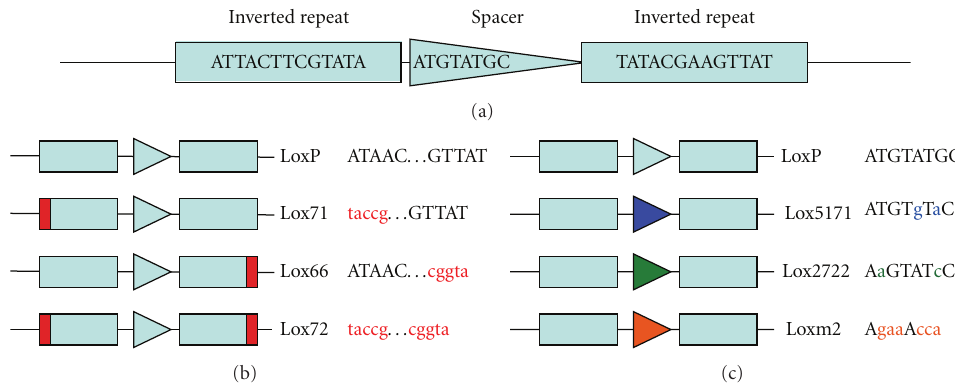
Figure 1: Lox site spacer and repeat variants. (a) LoxP site organization. Inverted repeats (rectangles) separated by spacer (triangle). (b) Lox inverted repeat variants. Red bar indicates location of divergence from LoxP. Right of the diagram are the name of the variant and the corresponding sequence. Variant specific sequence indicated in red in lower case. (c) Lox spacer variants. Spacer variant name and sequence indicated at right of diagram. Sequence variations from LoxP indicated in lower case in color of the spacer of the corresponding diagram.